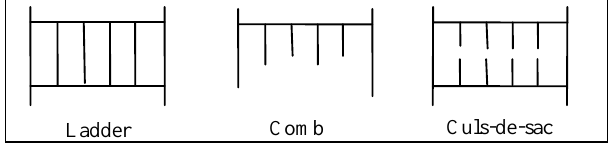
Ladder Culs-de-sac Figure 11. Resultant patterns started from ladder search